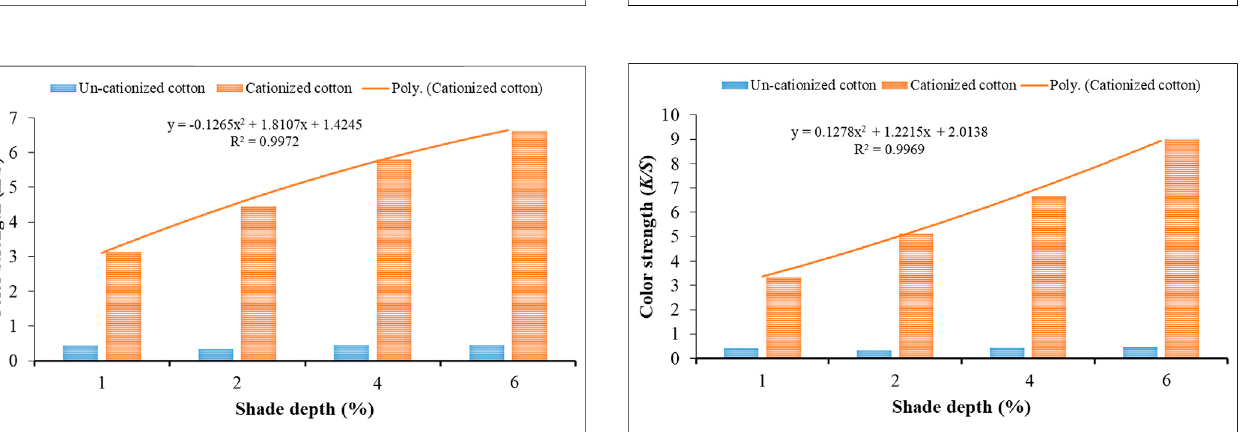
FIGURE 4 | Color strength ( K/S ) values of cationized (15 g/l) and un- cationized samples dyed with black tea extract.